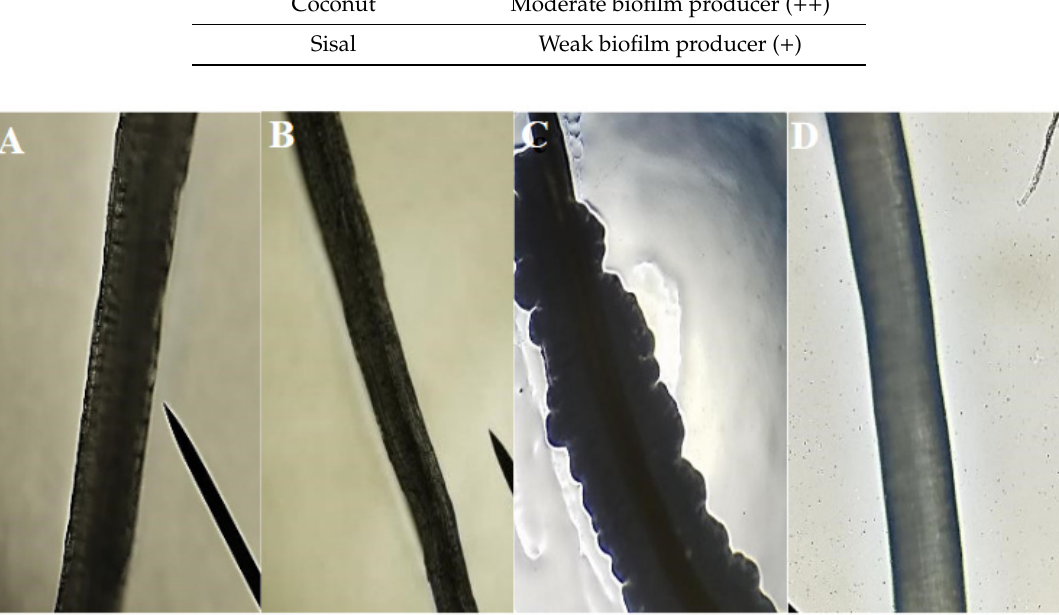
Figure 7. ( A ) Coconut fiber and ( B ) sisal fiber before performing the antifouling test to evaluate antibacterial properties with E. coli. ( C ) Coconut fiber and ( D ) sisal fiber after completing the biofilm formation test with DH5-alpha E. coli. Bacterial plaque formation is visible on the coconut fiber, supporting the quantitative results. The sisal fibers do not have a visible biofilm formation.